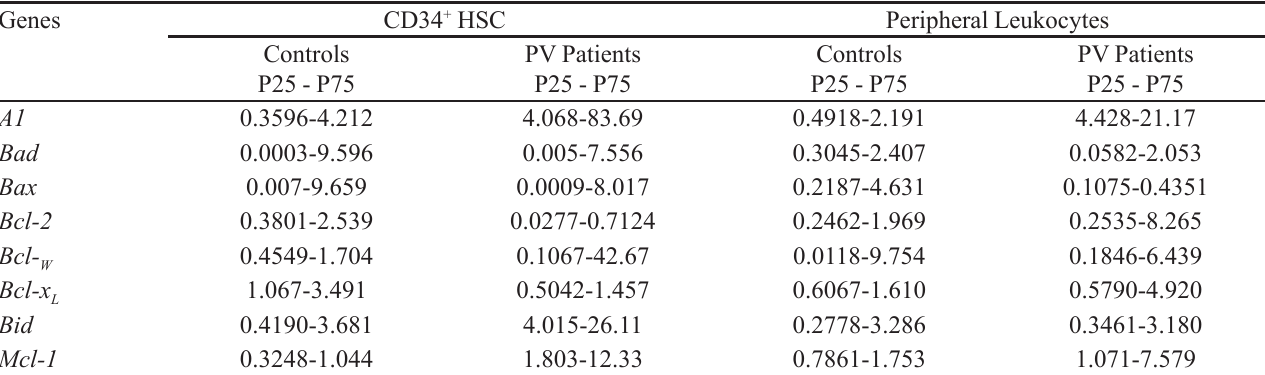
TABLE S1 - Percentiles 25 and 75 of gene expression 2 -∆∆Ct from Bcl-2 family members in hematopoietic stem cells and peripheral leukocytes in PV patients and